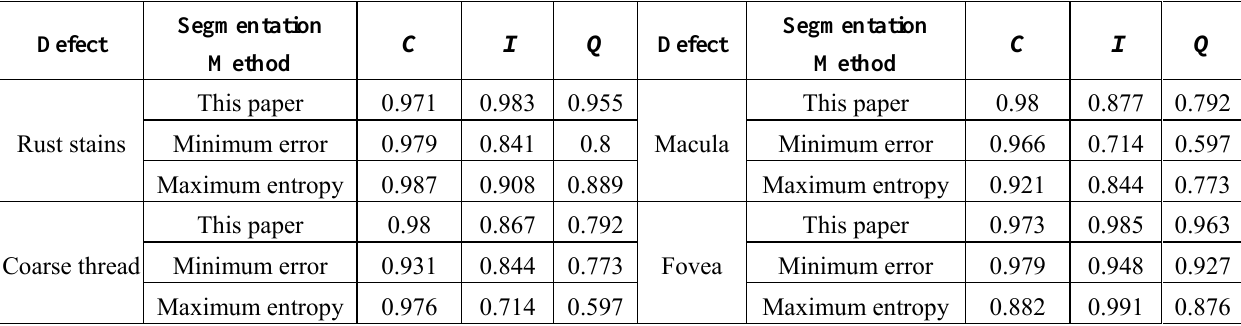
Table 4. Result of buffer region matching estimate.